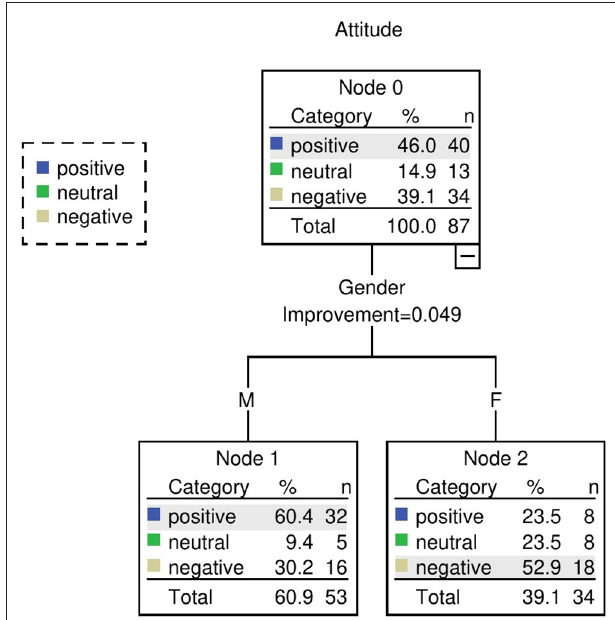
FIGURE 6 | Decision tree of attitudes of households that have faced livestock loss due to tiger in Sariska Tiger Reserve.